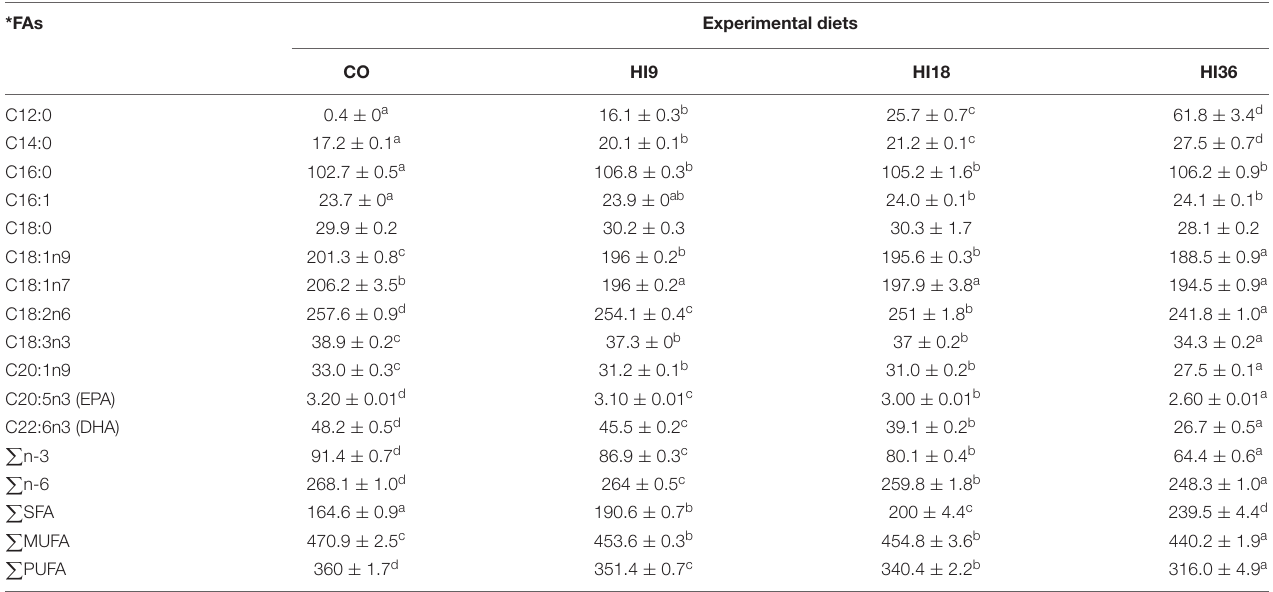
TABLE 2 | Fatty acid (FA) composition (as mg/g total FAs) of experimental